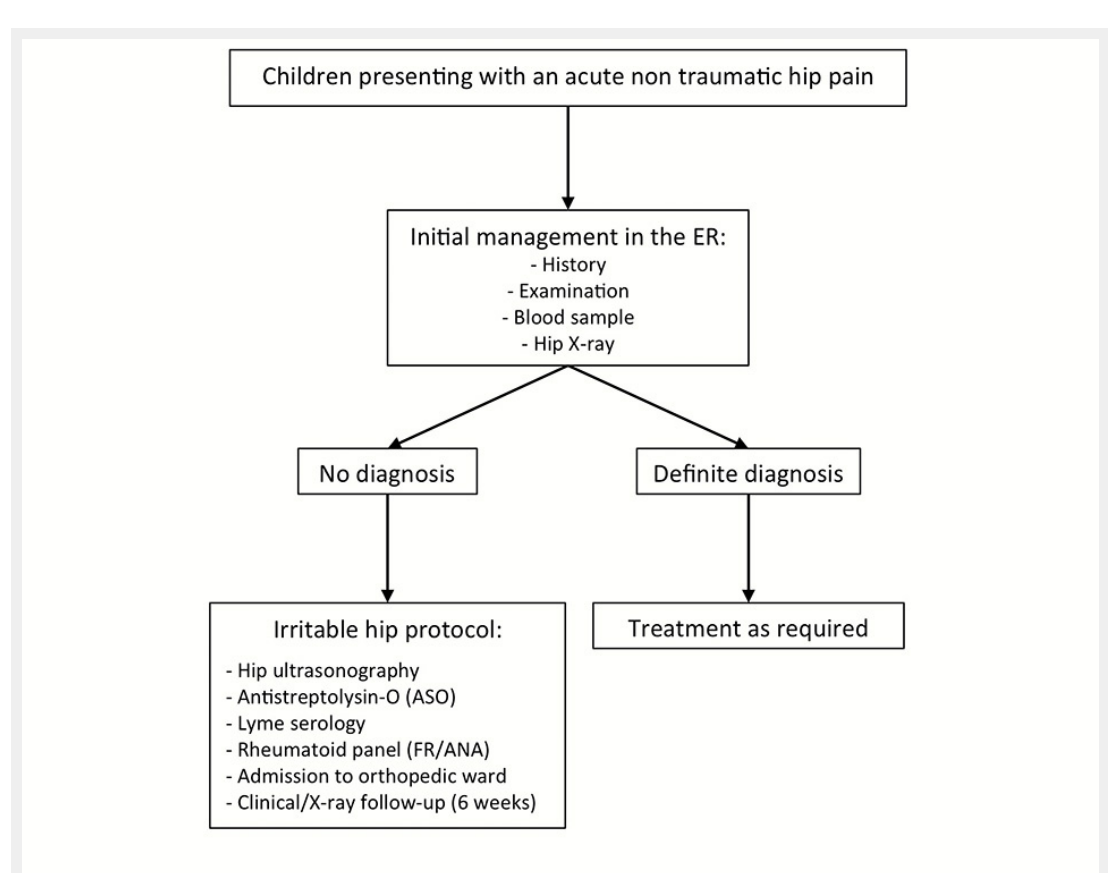
Management protocol of acute non-traumatic hip pain applied in our institution between 1999 and 2007. ANA = antinuclear antibodies; ASO = antistreptolysin O; ER = emergency room; RF = rheumatoid